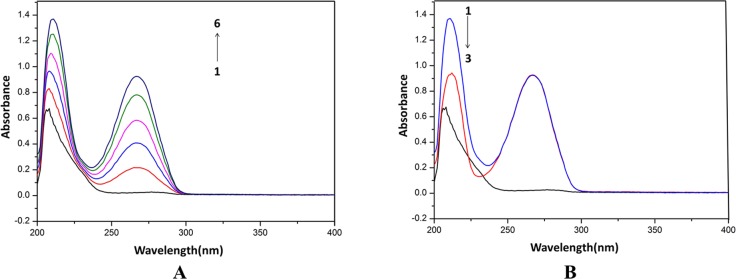
Effects of HEA on HSA by UV spectra.A: The concentration of HSA was 0.5 μM while the HEA concentration corresponded to 0, 10, 20, 30, 40 and 50 μM from (1 to 6). B: 1, 0.5 μM HSA + 50 μM HEA; 2, 50 μM HEA; 3, 0.5 μM HSA.